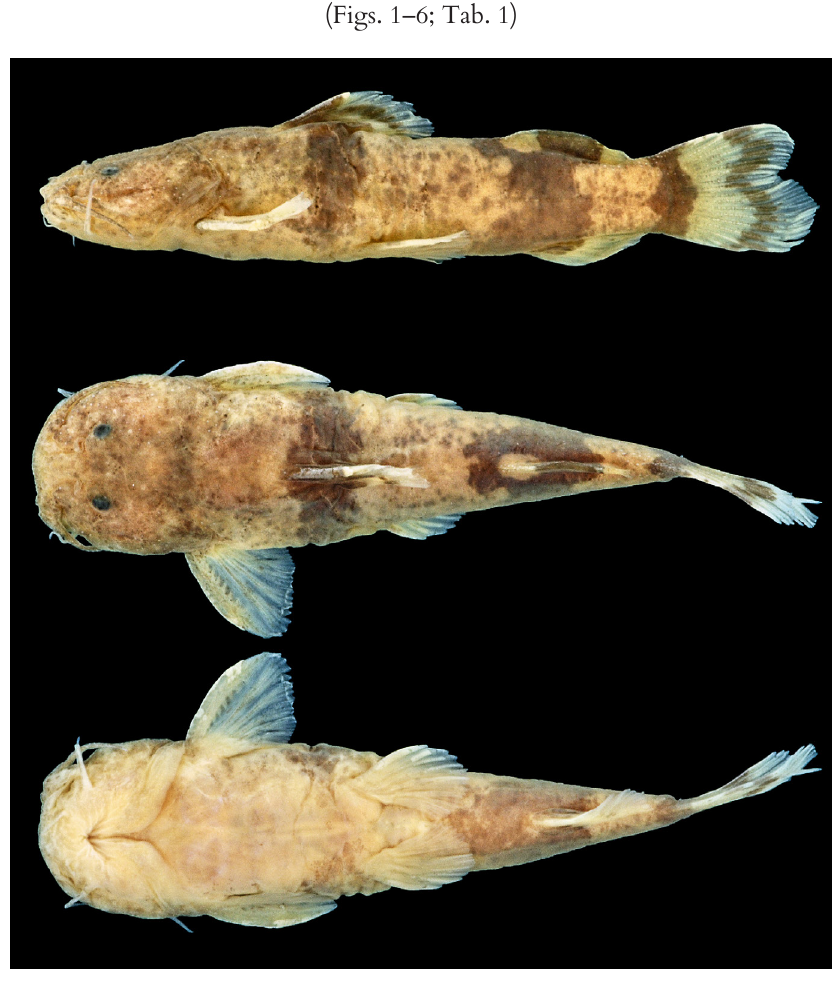
FIGURE 1 | Rhyacoglanis rapppydanielae , holotype, INPA 8060, 37.5 mm SL, rio Tocantins, state of Pará,